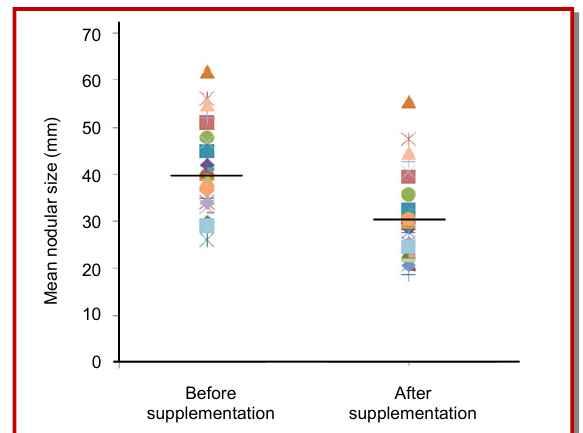
Figure 3: Mean nodular size (mm) before and after supplemen- tation with iron and folic